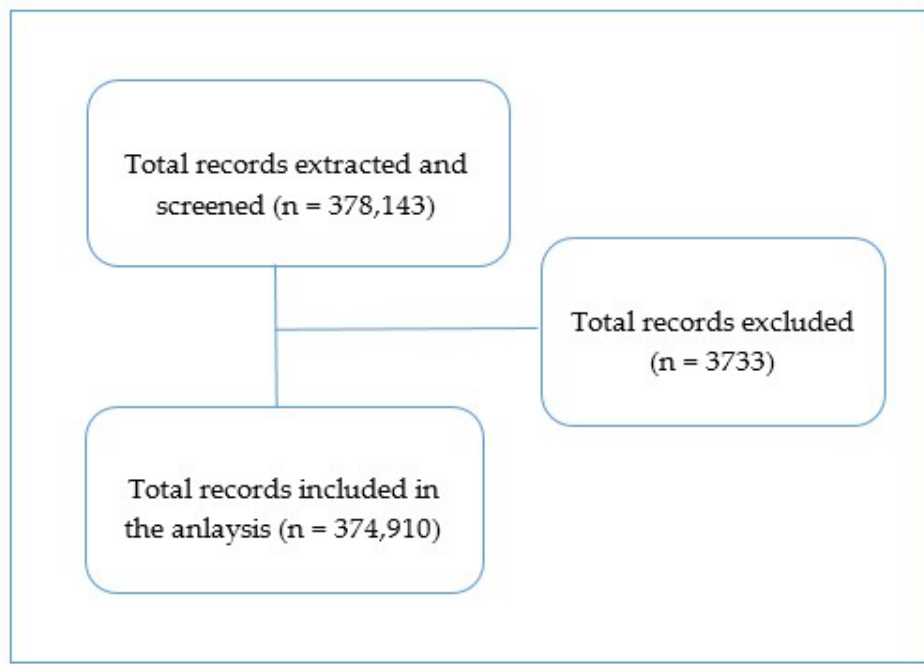
Figure 1. Flowchart of records screening and